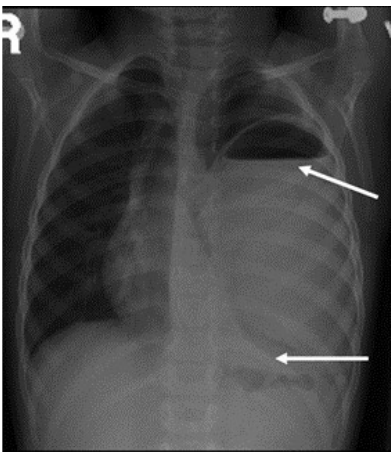
Figure 1. Large left-side cavity with a thick wall filled with thick fluid, with a clear fluid, with a clear fluid level occupying more than 80% of the left-sided lung. The arrows are pointing to the boundaries of the fluid level with mild compression of the mediastinum to the other side and secondary hyperinflation of the right